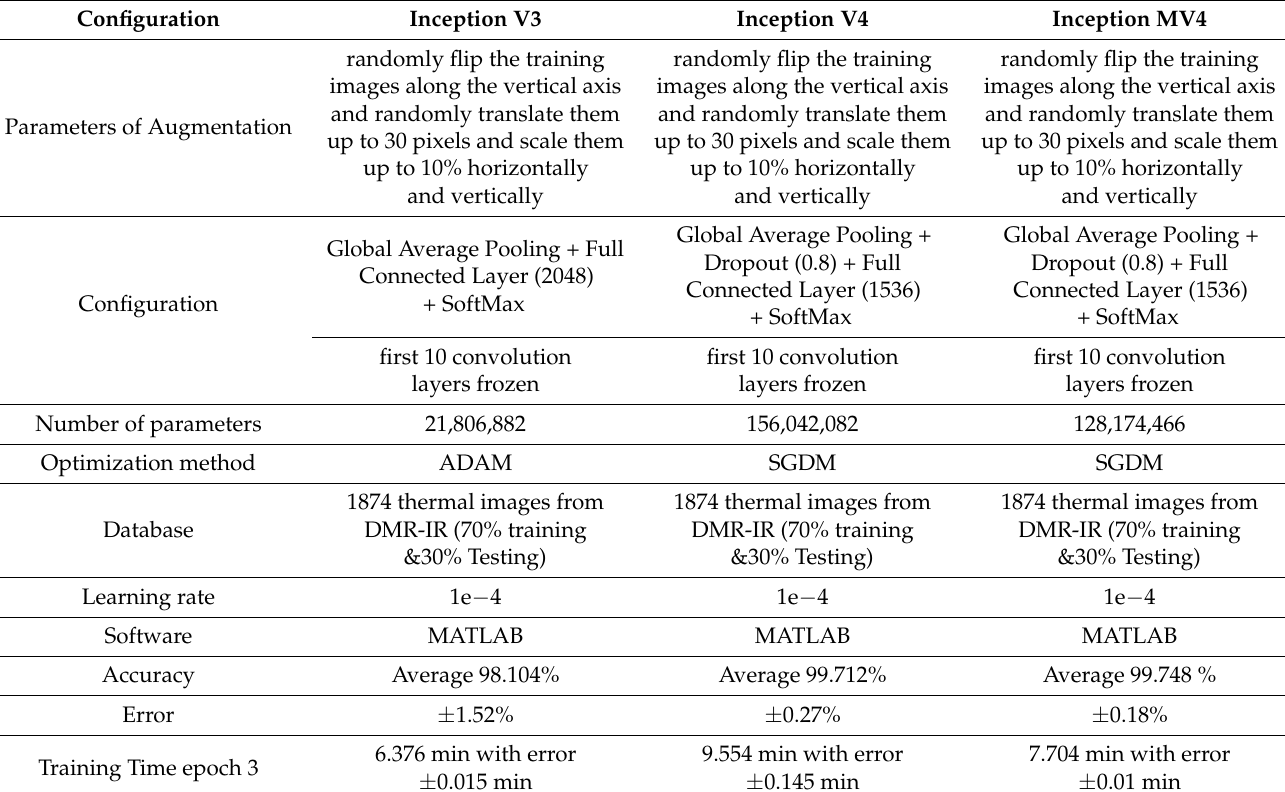
Figure 4. A GUIDE for breast cancer diagnosis from thermal images.